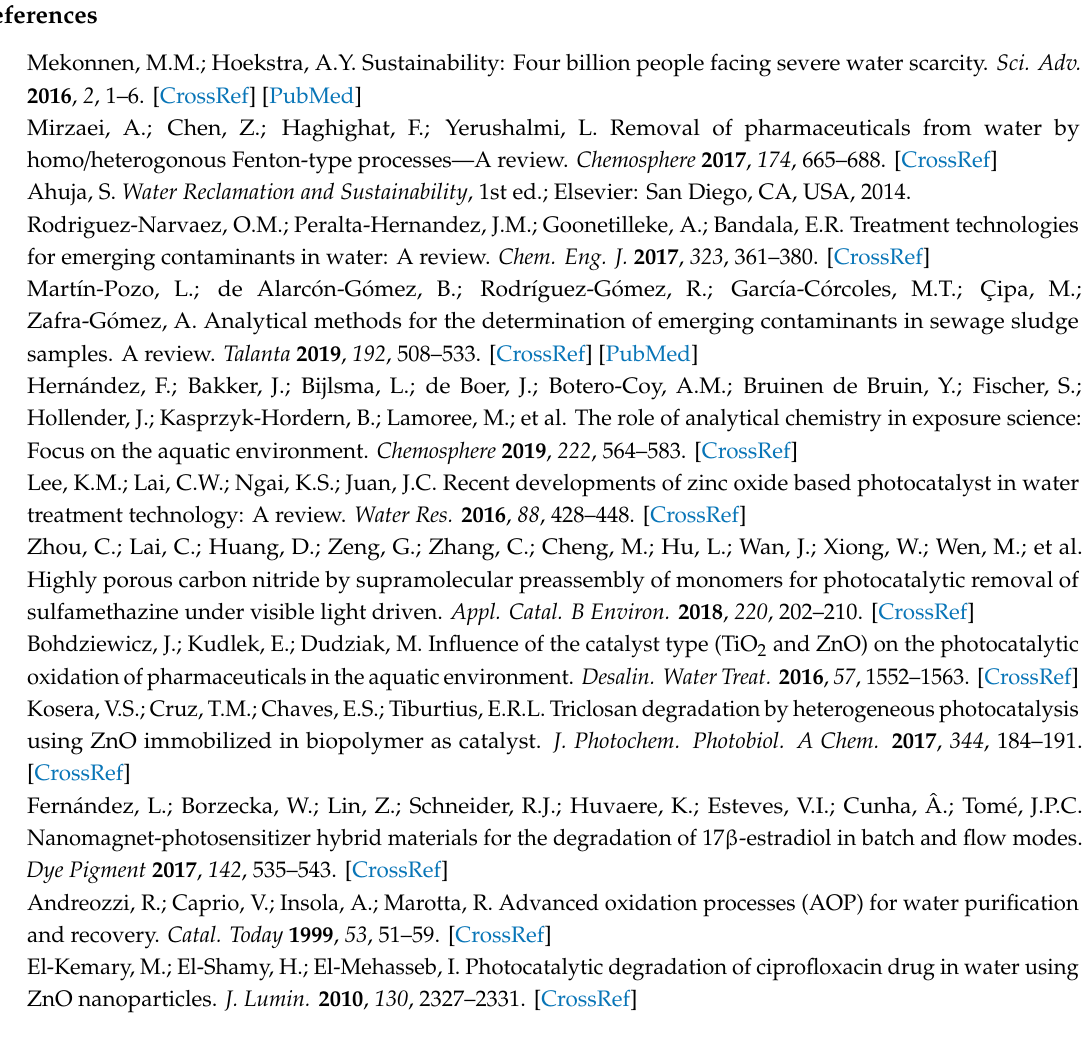
Figure S1: AFM topography image and line profiles of small Ag nanoclusters deposited on